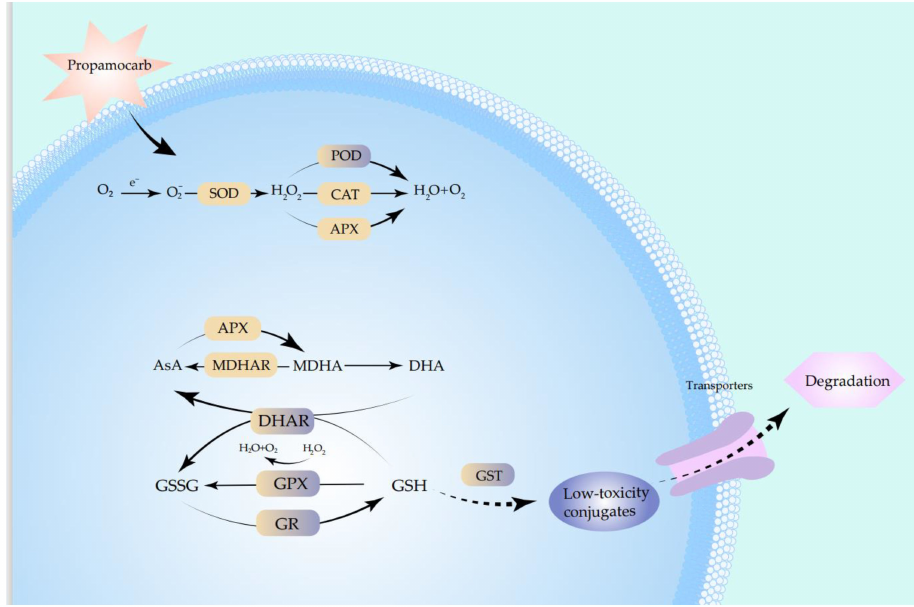
Figure 9. Hypothetical model of propamocarb metabolism and detoxification in cucumber.